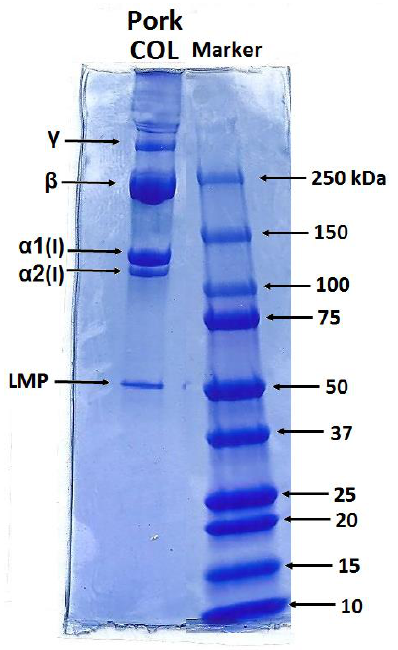
Figure 1. Polypeptide pattern of type COL I isolated from porcine skin. The FTIR spectrum of isolated COL and COL submitted to ethanol sterilization can be seen in Figure 2. The spectrum contained five amidic bands. The peak, centered at 3330 cm −1 , comprised a mutual band of hydrogen bonds from the intermolecular water and amide A of collagen, which was associated with N-H stretching. The band at ∼ 3100 cm −1 , quoted as amide B, is a common band for C – H stretching in the sp2 hybridization and stretching vibration of the N-H bonds in secondary amides. Generally, amide I bands ( ∼ 1650 cm −1 ) originate from C=O stretching vibrations coupled with N – H bending vibra- tion. Amide II bands ( ∼ 1550 cm −1 ) arise from N – H bending vibrations coupled with C – N stretching vibrations [37]. Another source of evidence of the existence of a triple helical structure is the presence of a quartet of bands at ∼ 1205, 1240, 1280 (amide III) and 1338 cm −1 [38]. Bands in spectral region 2800 – 2900 cm −1 belonged to C-H aliphatic bonds and the bands at 1745 cm −1 , ascribed to the C=O bonds in esters, were related to the presence of lipids. The different intensities of the lipid bands in both materials were caused by dif- ferent lipid concentrations in both materials. Low intensity bands in spectral region of 990 – 1100 cm −1 belonged to carbohydrates, which were represented by GAGs. Both lipids and GAGs are residual impurities remaining in collagen after the isolation procedure [39]. Changes in the positions and intensities of individual amide bands could be associated with changes in the secondary structure of collagen. As shown in Figure 2, the use of eth- anol as a sterilization agent did not change the secondary structure of COL.